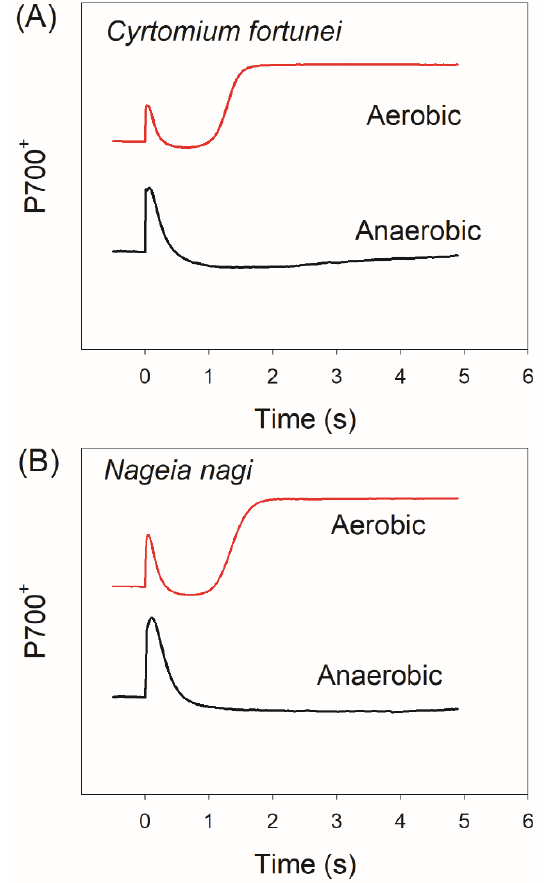
Figure 1. Redox kinetics of P700 upon transition from dark to actinic light (1809 µ mol photons m −2 s −1 ) in leaves of Cyrtomium fortune ( A ) and Nageia nagi ( B ) measured under aerobic and anaerobic conditions. The data are the means of five independent leaves from five independent plants.